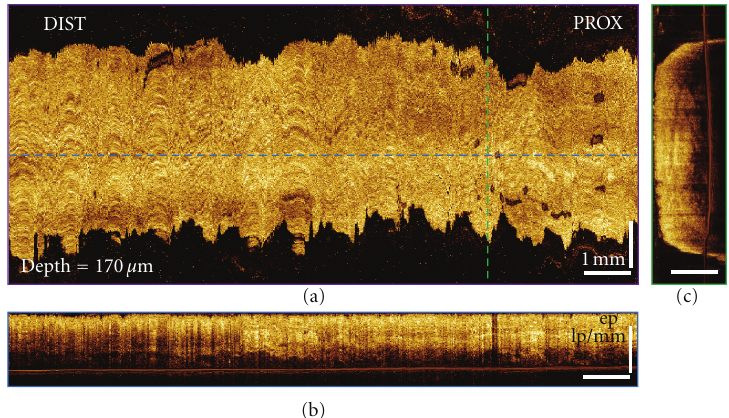
Figure 4: 3D-OCT orthoplanes from the BE region before CSA treatment. (a) The en face orthoplane is located at a depth of 170 µ m. The colored dotted lines indicate location of complementary orthoplanes (b) and (c). (b) The cross-sectional YZ orthoplane shows the epithelium (ep), lamina propria (lp), and muscularis mucosa (mm). (c) The cross-sectional XZ orthoplane shows the typical BE